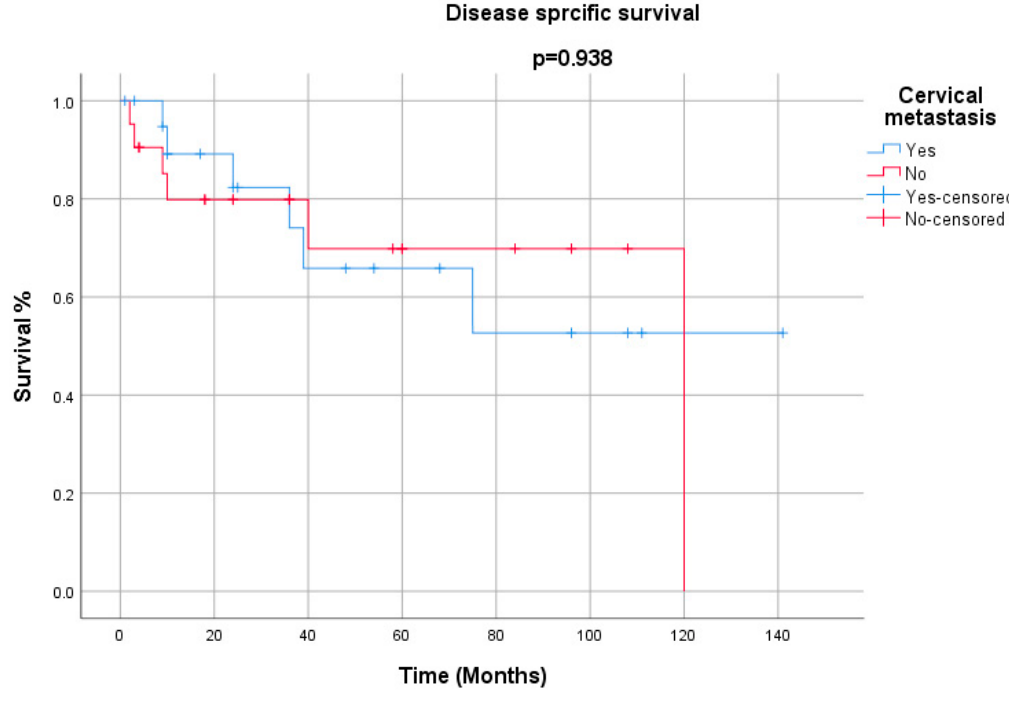
Figure 4. Disease-specific survival for cervical metastasis.